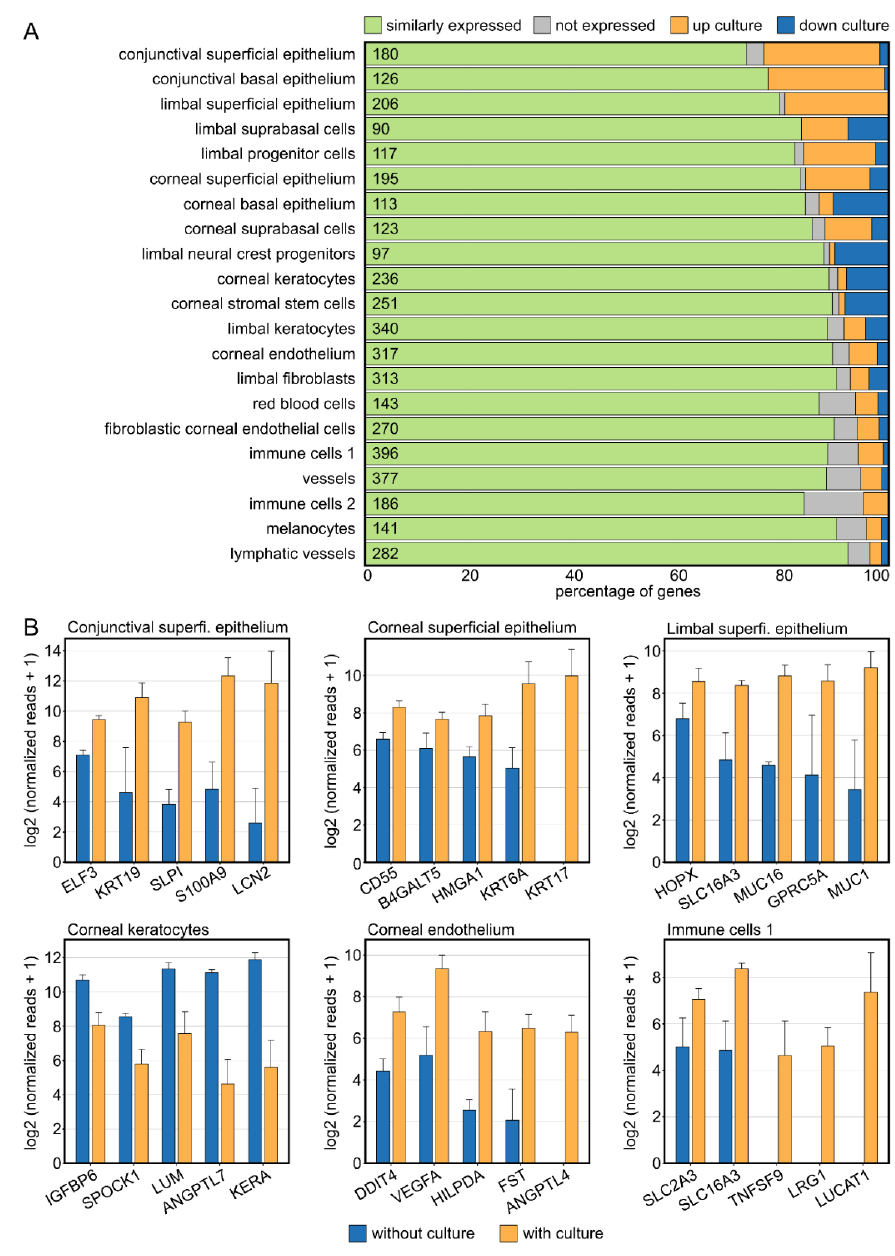
Figure 3. Corneal tissue culture significantly modulates the corneal cellular composition. ( A ): Impact of tissue culture on the expression profile of corneal cell type-specific marker genes, as previously determined by single-cell RNA sequencing. The number of marker genes for each cell type is shown within the plot. ( B ): The top five differentially expressed cell-type-specific marker genes are visualized for the most affected cell types. The height of the bar corresponds to mean expression and the error bar represents standard deviation.